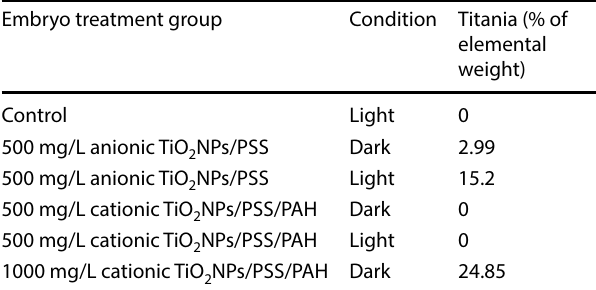
Table 1 Trace amounts of titania detected on the surface (chorion) of embryo samples (n = 5) exposed to different coated titania treat- ments using EDS-TEM analysis